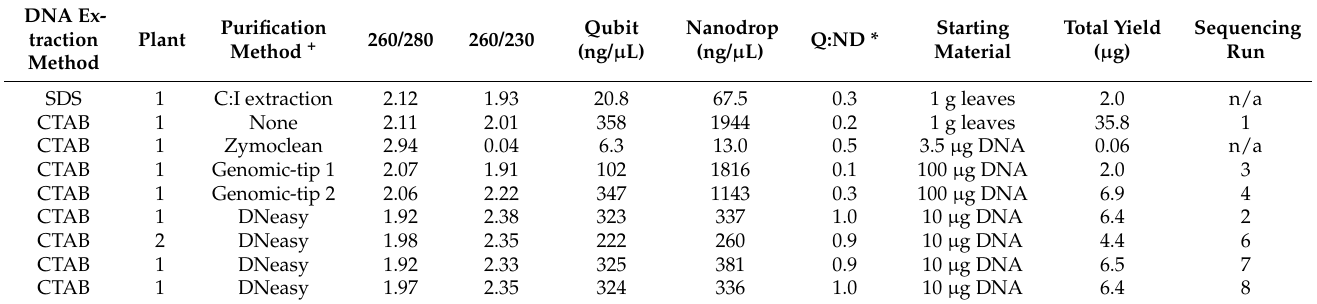
Table 1. Yields and quality metrics for rooibos DNA samples from two rooibos plants generated using various DNA extraction and purification procedures.